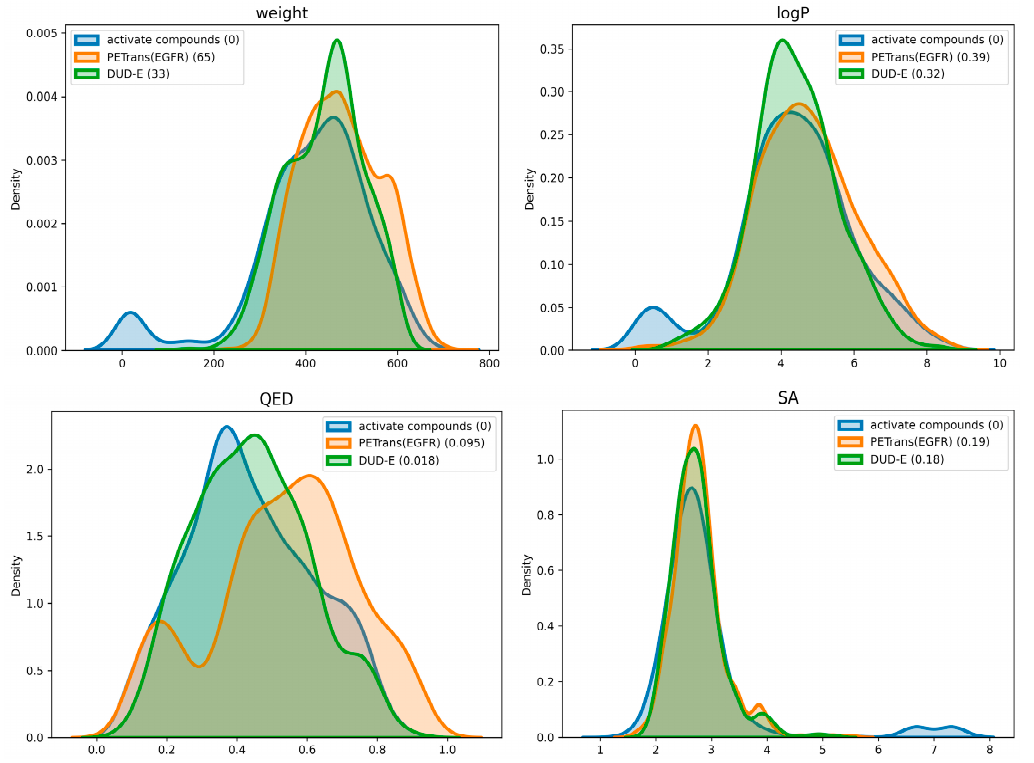
Figure 5. Chemical property distributions for the transfer learning dataset and the generated set of molecules. Wasserstein-1 distances from the transfer learning dataset are given in parentheses. Parameters: MW, LogP, QED, and SA.